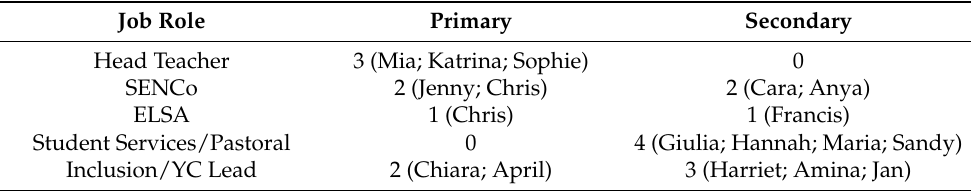
Table 1. Table showing the job role and school type of participants. Job